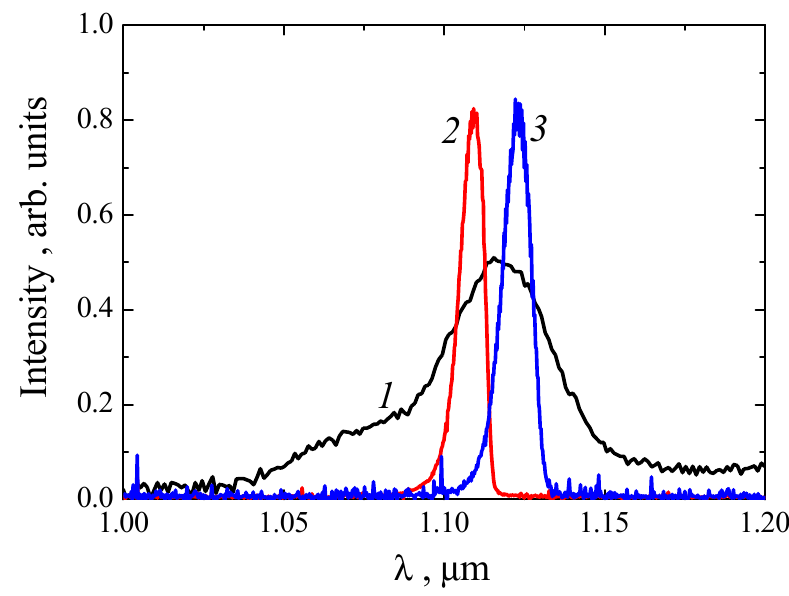
Figure 5. The PL spectra of the sample D (curve 1) and the stimulated emission spectra of the samples D (curve 2) and E (curve 3).